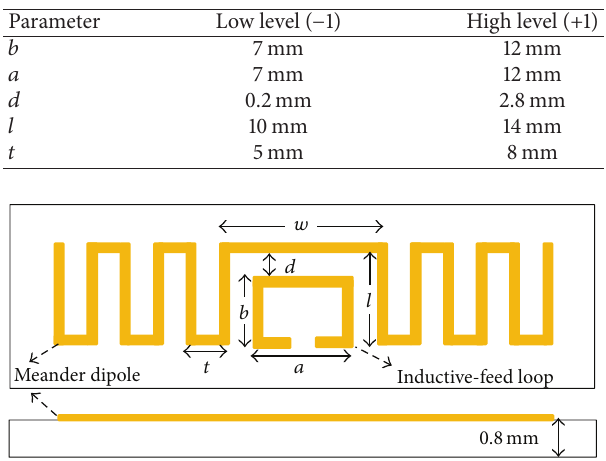
Figure 2: The benchmarking configuration of the inductive-feed meander dipole.